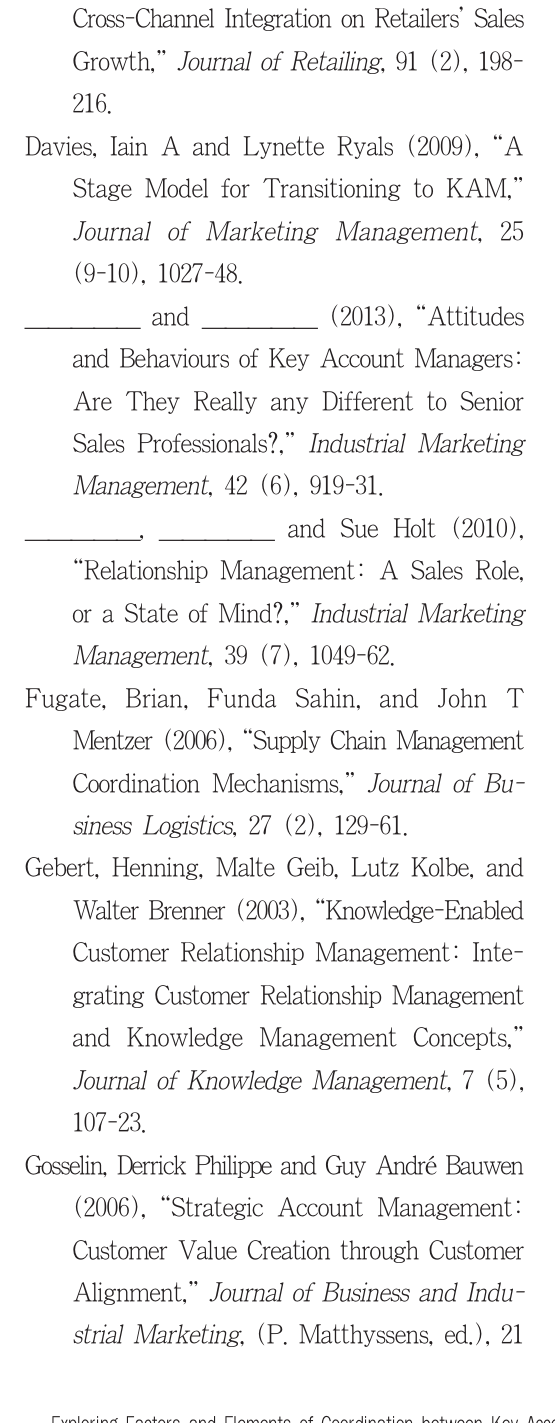
Exploring Factors and Elements of Coordination between Key Account Management Units and Non-key Account Management Units